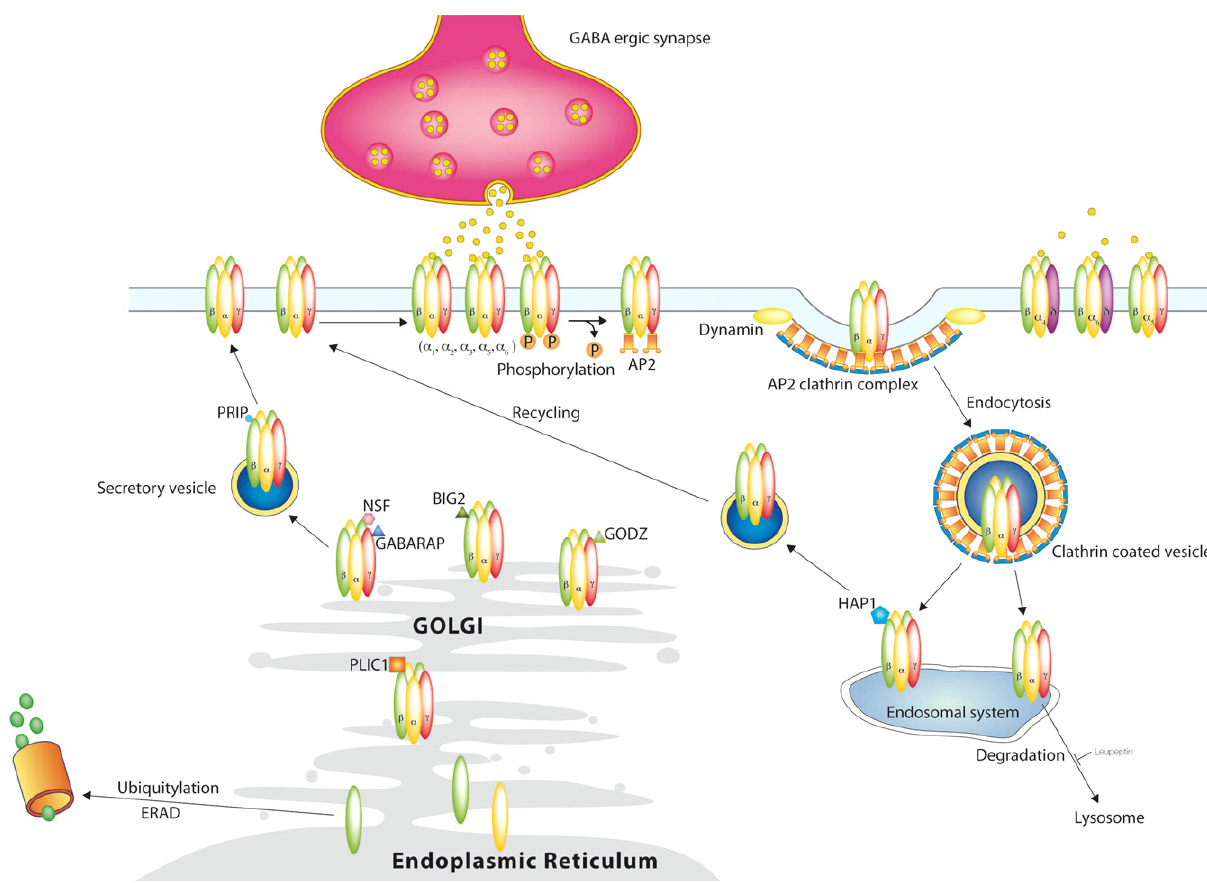
Figure 2. GABA receptor traffi cking. GABA receptors are synthesized and assembled in the Endoplasmic Reticulum and matured in the Golgi and reach the A A surface outside of synapses through the secretory path. Synaptic receptors reach their destination through lateral movement in the plasma membrane, where they mediate phasic inhibition. Extrasynaptic receptors are activated by lower concentrations of GABA in the extracellular space and mediate tonic inhibition. Phosphorylation not only affects receptor function, but also regulates their removal from the surface through clathrin mediated endocytosis. From the endosomal system the receptors are either recycled to the surface or degraded in the lysosomes. This degradation can be blocked by leupeptin. Another degradation system works through the proteasome after